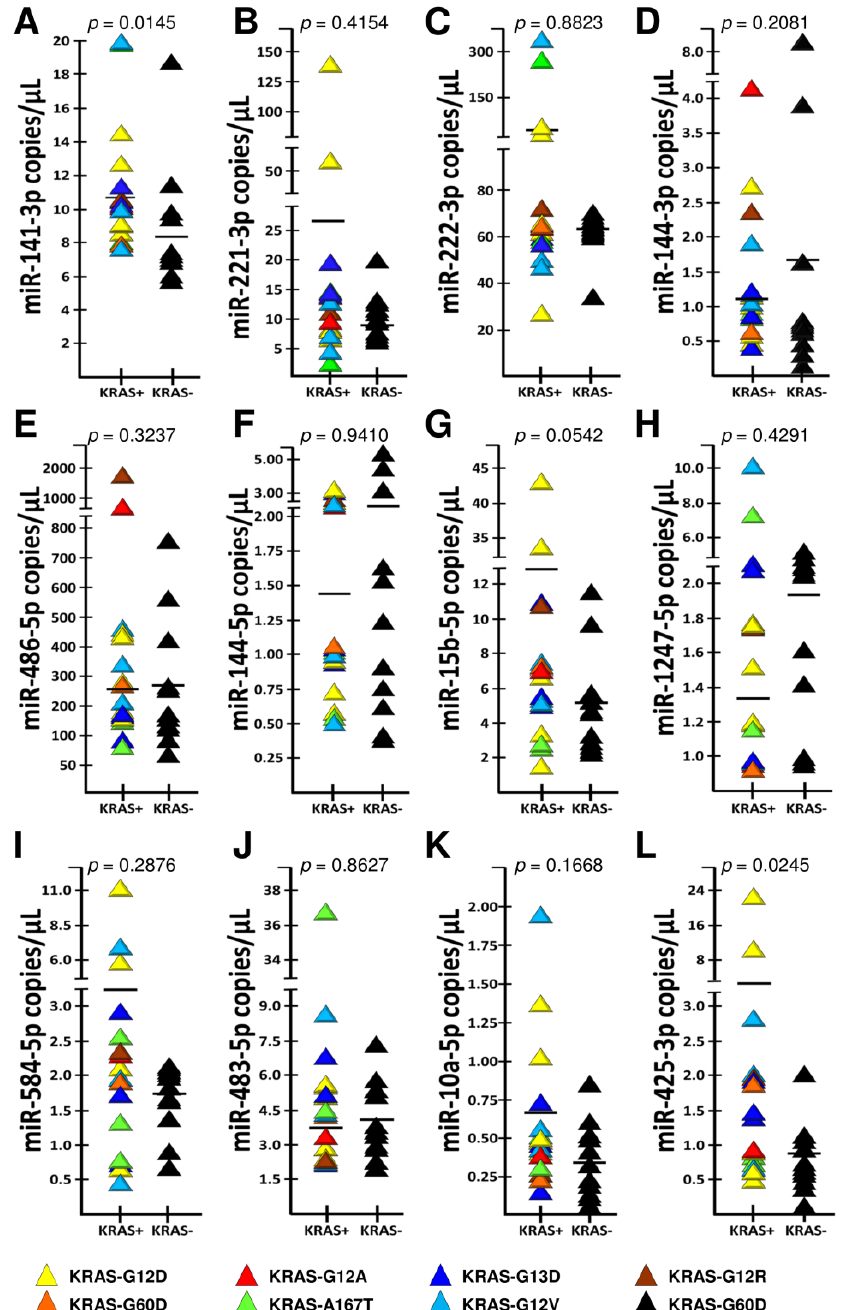
Figure 6. Correlation between miRNA dysregulation and KRAS mutations. ( A – L ): dd-RT-PCR comparison of plasma samples from KRAS -MUT vs. KRAS -WT CRC patients (see Figure 4) with respect to content of dys-regulated miRNAs, including miR-141-3p ( A ), miR-221-3p ( B ) and miR-222-3p ( C ).